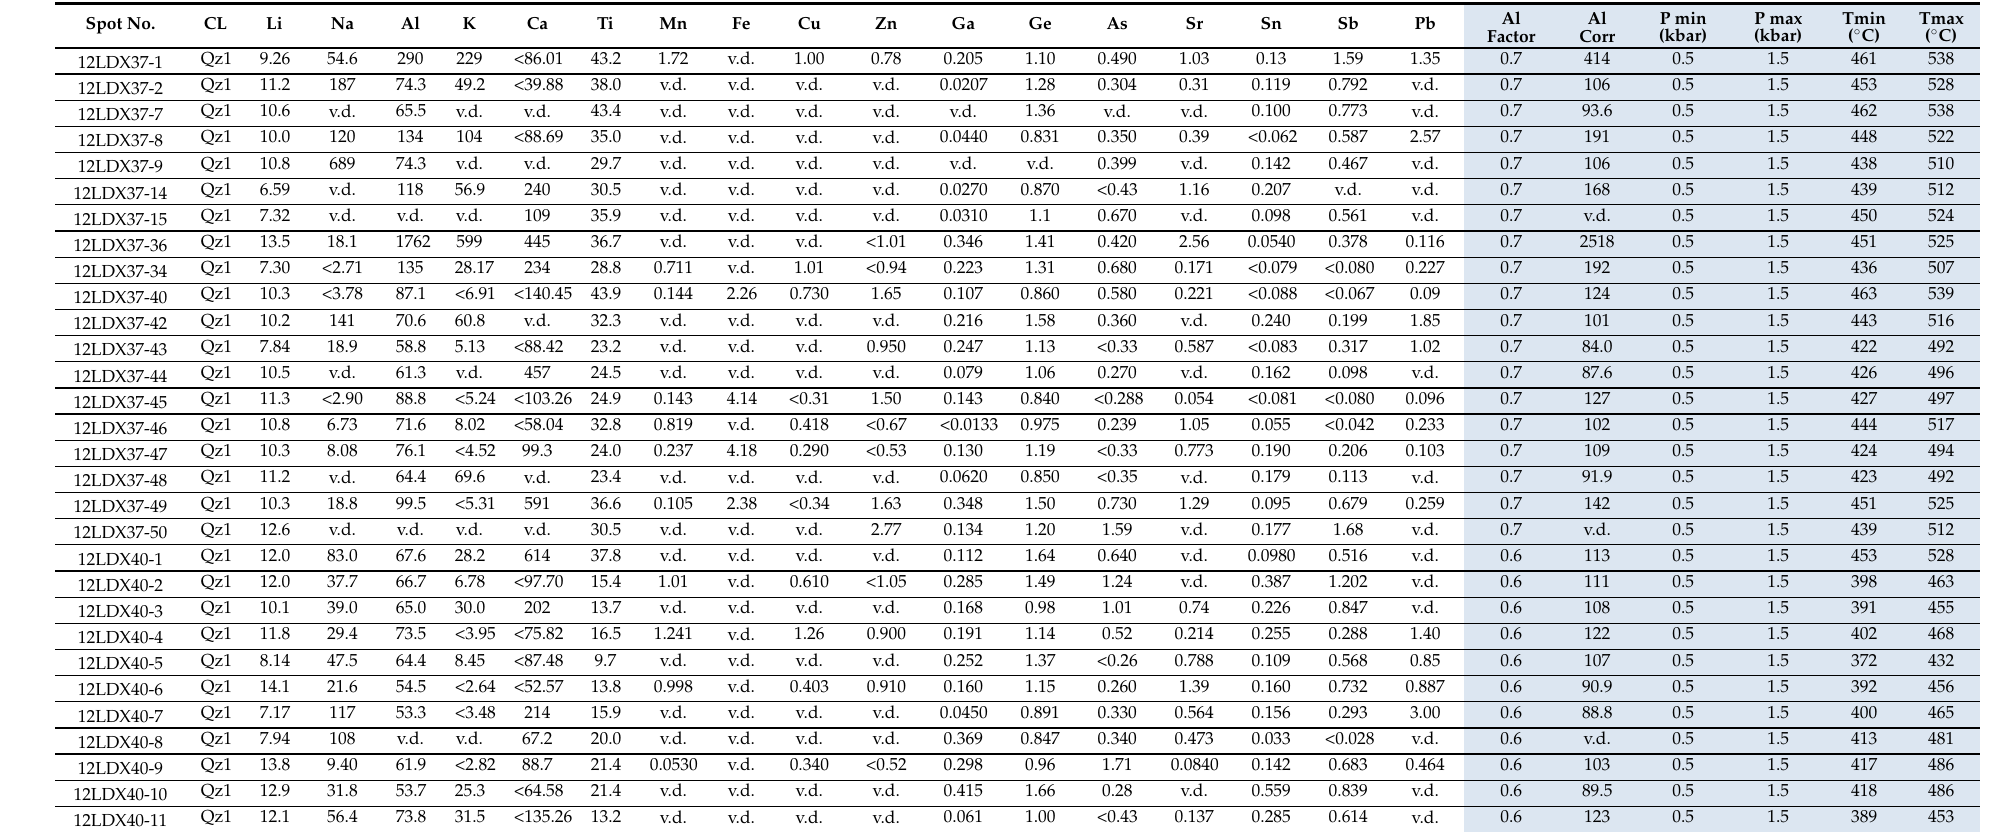
Table 4. LA-ICP-MS trace elements in quartz of the Tongchang porphyry Cu